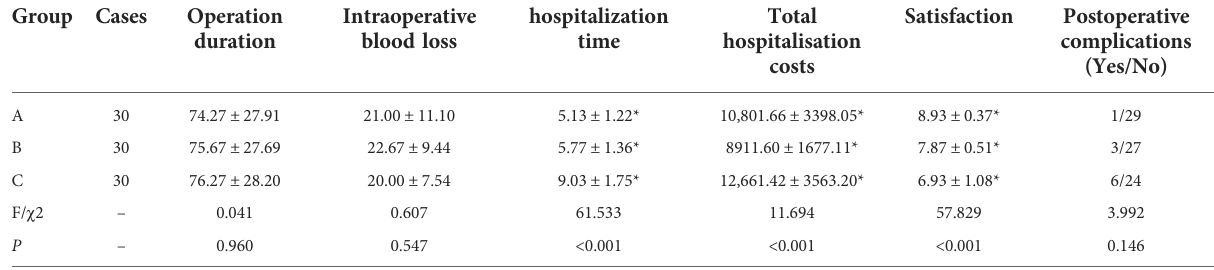
TABLE 3 Comparison of surgery-related data among three groups